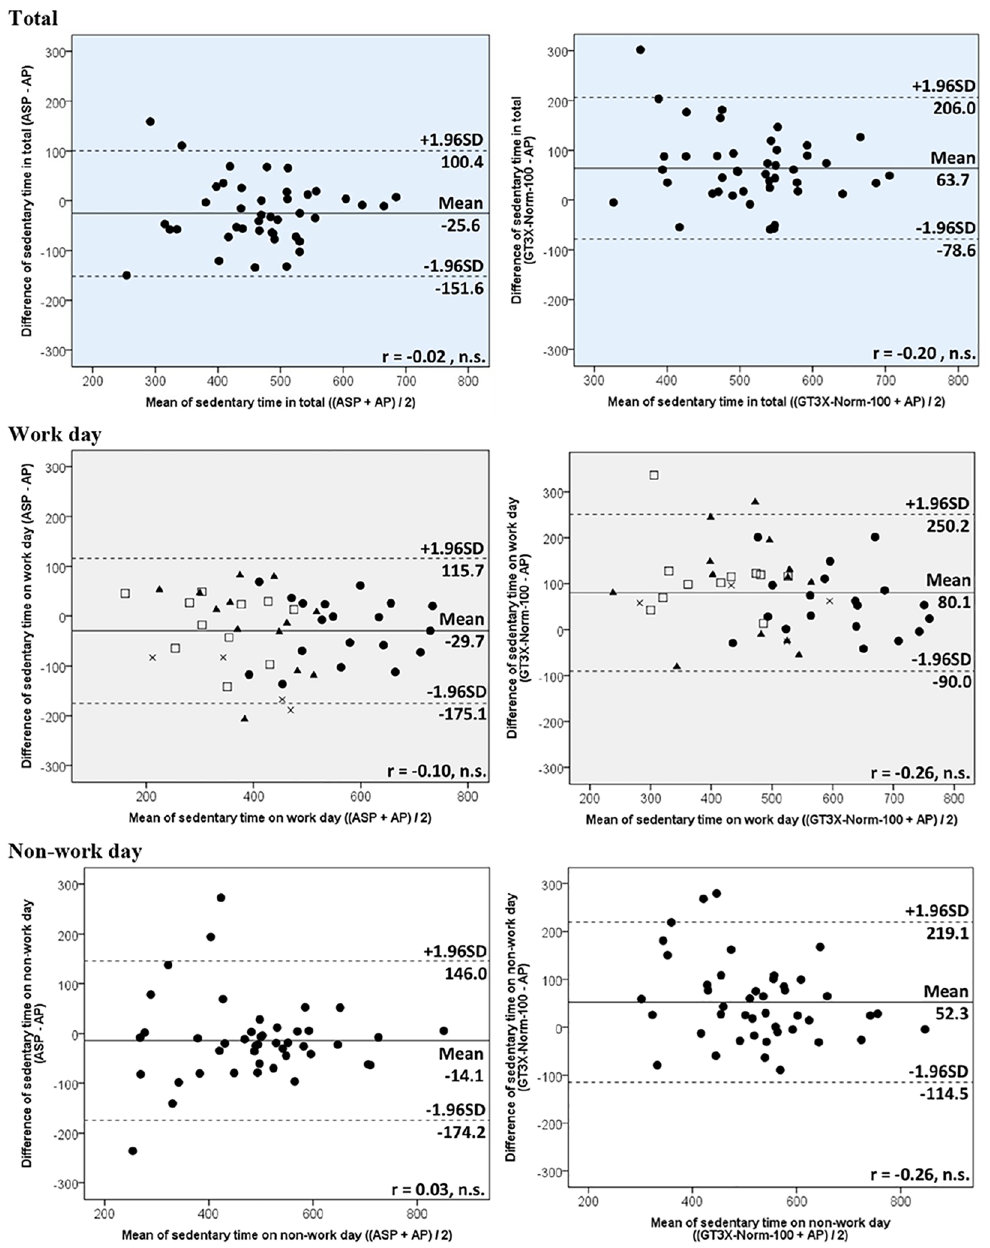
Fig 1. Bland-Altman plots of total sedentarytime between monitors. The shape of the relationshipson work days represent participants’ usual task at work; ● - sitting task, ▲ - standingtask, □ - walkingtask, × - physical task. Solid horizontallines represent mean difference and dashedlines represent levels of